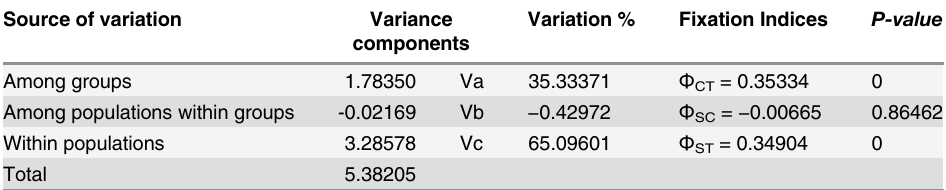
Table 3. Analysis of molecular variance (AMOVA) based on the mitochondrial control region se- quences of the Azorean barnacle, Megabalanus azoricus . Source of variation Variance Variation % Fixation Indices P-value components Among groups Among populations within groups Φ SC = − 0.00665 0.86462 Within populations 3.28578 Φ ST = 0.34904 Total